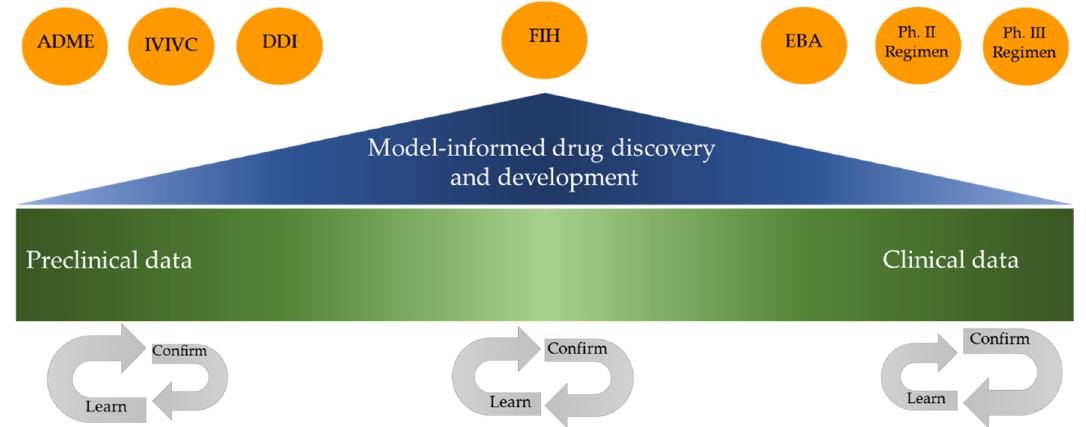
Figure 1. Illustration of the role of Model-Informed Drug Discovery and Development (MID3) and the application across preclinical to clinical drug development.